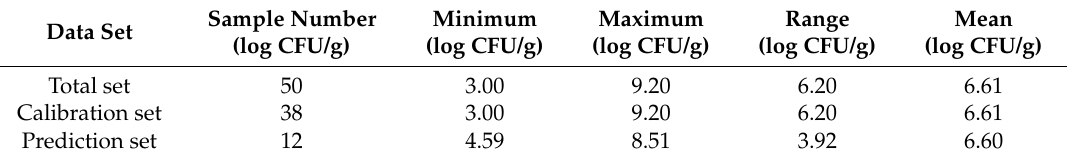
Table 1. Results of total viable count (TVC) in pork samples that include calibration set and prediction set by reference